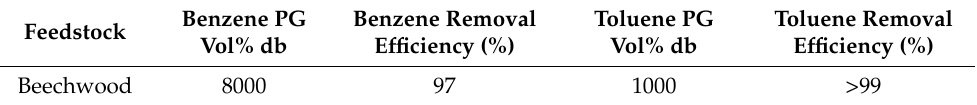
Table 8. Benzene and toluene removal efficiency in AREA-5 with beechwood gasification. Feedstock